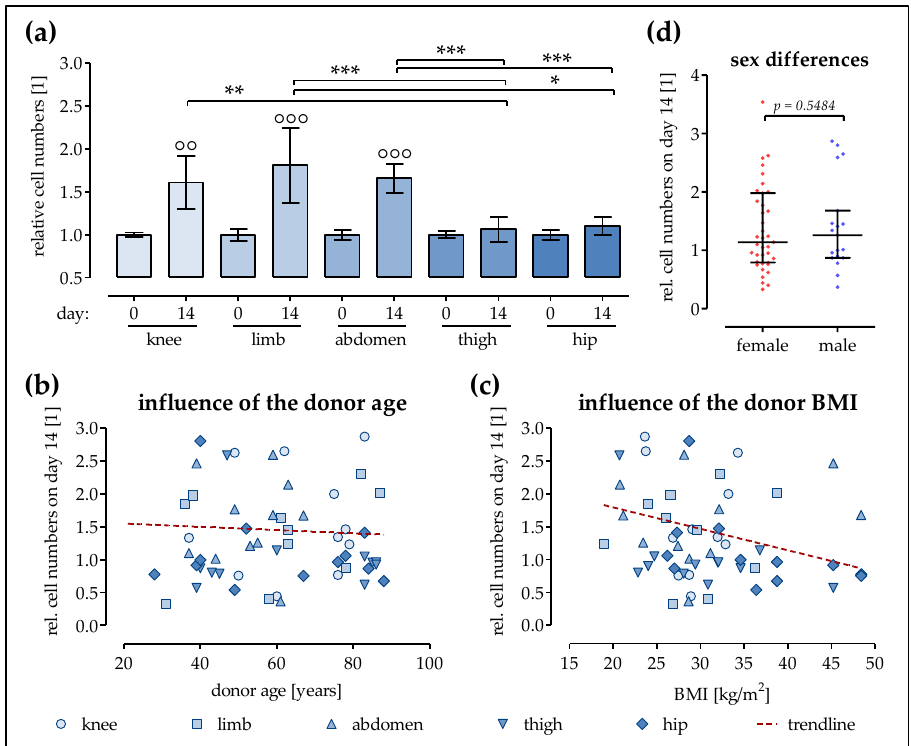
Figure 1. The proliferation of mesenchymal stem/stromal cells from adipose tissue (Ad-MSCs) varies depending on the donor site. Ad-MSCs derived from adipose tissue of the knee ( N = 12), limb ( N = 11), abdomen ( N = 11), thigh ( N = 12), and hip ( N = 12) were osteogenically differentiated for 14 days. ( a ) To determine cell proliferation, the total protein content was determined by Sulforhodamine B (SRB) staining on days 0 and 14 of differentiation; ( b ) Relative cell numbers on day 14 of differentiation as a function of the donor age; ( c ) Relative cell numbers on day 14 of differentiation as a function of the donor body mass index (BMI); ( d ) Comparison of the relative cell numbers of differentiated (day 14) Ad-MSCs from male and female donors; °° p < 0.01 and °°° p < 0.001 when comparing day 0 with day 14 within each group; * p < 0.05, ** p < 0.01, and *** p < 0.001 as indicated.